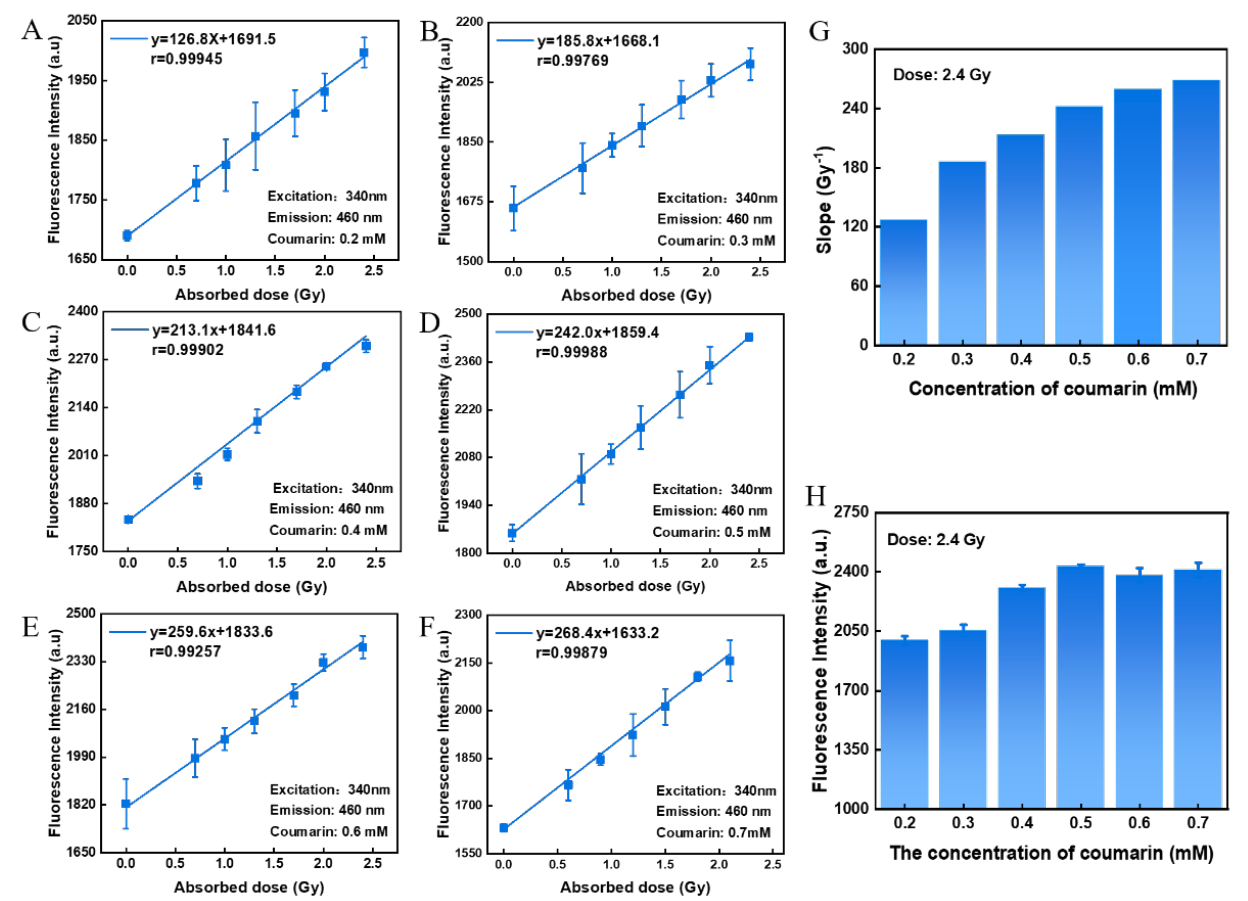
Figure 3. Effect of COU concentration on the fluorescence intensity and dose-response of hydrogel sensors. ( A – F ) The relationship between dose and fluorescence intensity with 0.2 mM, 0.3 mM, 0.4 mM, 0.5 mM, 0.6 mM, and 0.7 mM of COU. ( G ) The effect of COU concentration on the slopes of their linear fitting. ( H ) The effect of COU concentration on the fluorescence intensity of the hydrogel sensor. The concentration of GNPs was 0.1 mM and the mass fraction of agarose was 2 wt%.